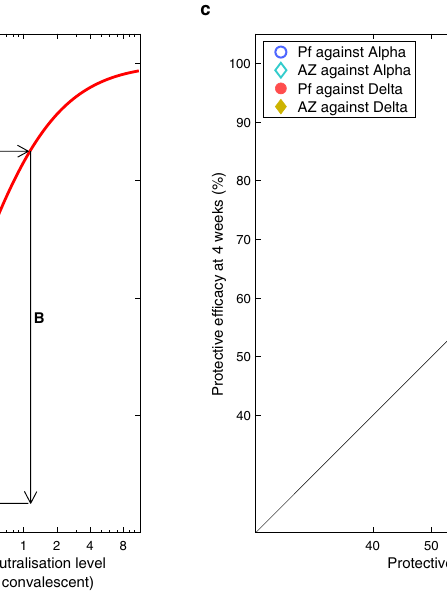
reduced accordingto thevaluesobtainedbytheCom-COVstudy 18 ;(stepsD-E)the reduced neutralisationlevelis translatedto areduced ef fi cacyfor the shorterdose interval. c The consequences of this process for the AstraZeneca (AZ) and P fi zer (PF)vaccinesagainst the Alpha and Delta variants, and hencethe modi fi ed vaccine ef fi cacy estimates for model